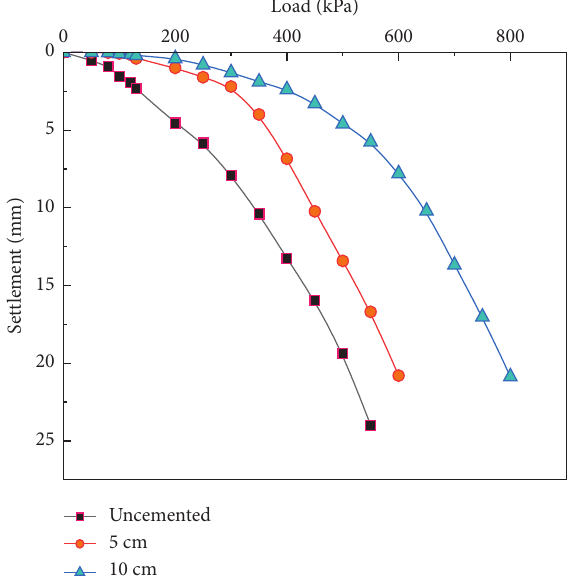
Figure 12: Bearing capacity of cemented calcareous sand with the different layer thickness.